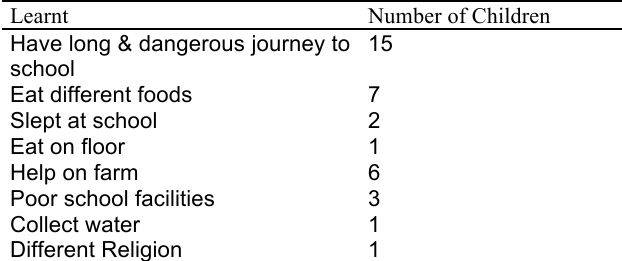
Table 1. The things children claim to have